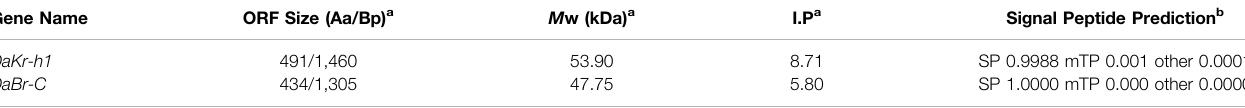
TABLE 2 | Physicochemical properties and cellular localization of DaKr-h1 and DaBr-C of D. armandi